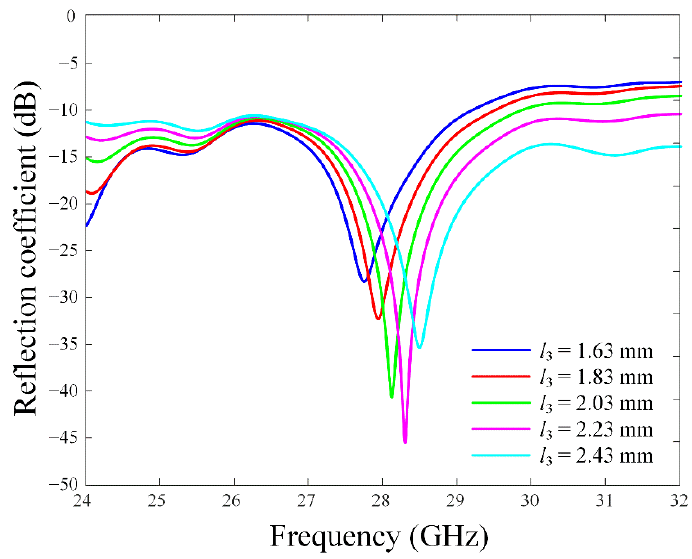
Figure 4. Reflection coefficients in accordance with the parameter l 3 .